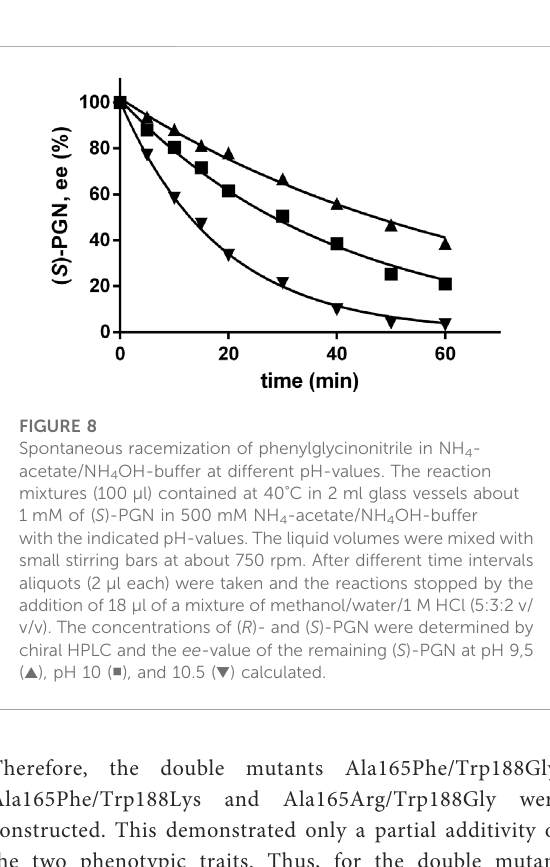
FIGURE 7 Strecker synthesis in NH 4 -acetate/NH 4 OH-buffer at pH 9.5 using different KCN to benzaldehyde ratios. The reaction mixtures (300 μ l) contained at 40 ° C in 3 ml glass vessels 100 mM benzaldehyde and varying KCN concentrations [ (A) , 100 mM, (B) 150 mM and (C) , 300 mM] in 0.5 M NH 4 -acetate/NH 4 OH- buffer (about 0.95 M of ammonia-ions) at pH 9.5. The liquid volumes were mixed with small stirring bars at about 750 rpm. A separate experiment was performed for each time point. At the indicated times, the reactions were stopped in the individual vessels by the addition of 2.7 ml of a mixture of methanol/water/ 1 M HCl (5:3:2 v/v/v) and the mixtures were stirred at room temperature with 750 rpm for further 30 min. The concentrations (cid:129) ), phenylglycinonitrile ( > ), of benzaldehyde ( ○ ), mandelonitrile ( and phenylglycine amide ( ◆ ) were determined by HPLC.